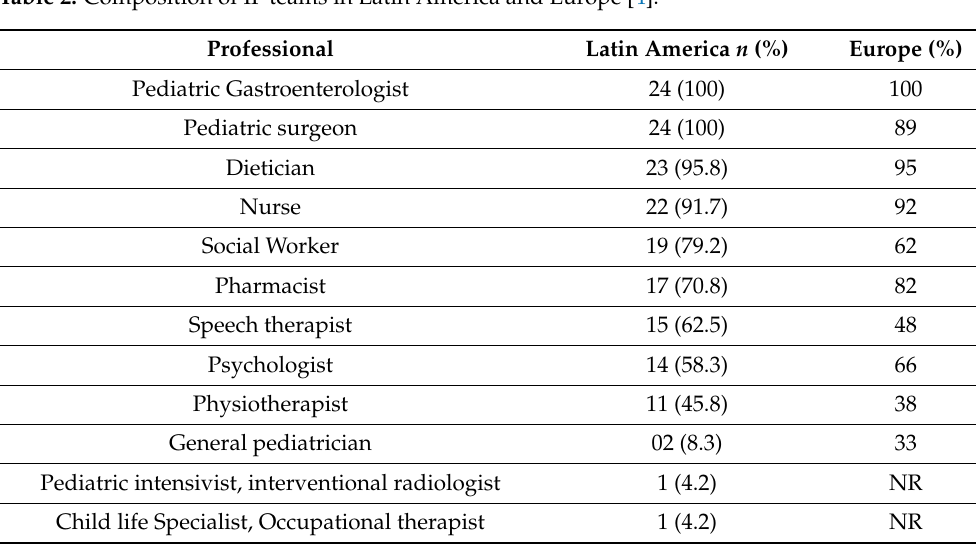
Table 2. Composition of IF teams in Latin America and Europe [4].